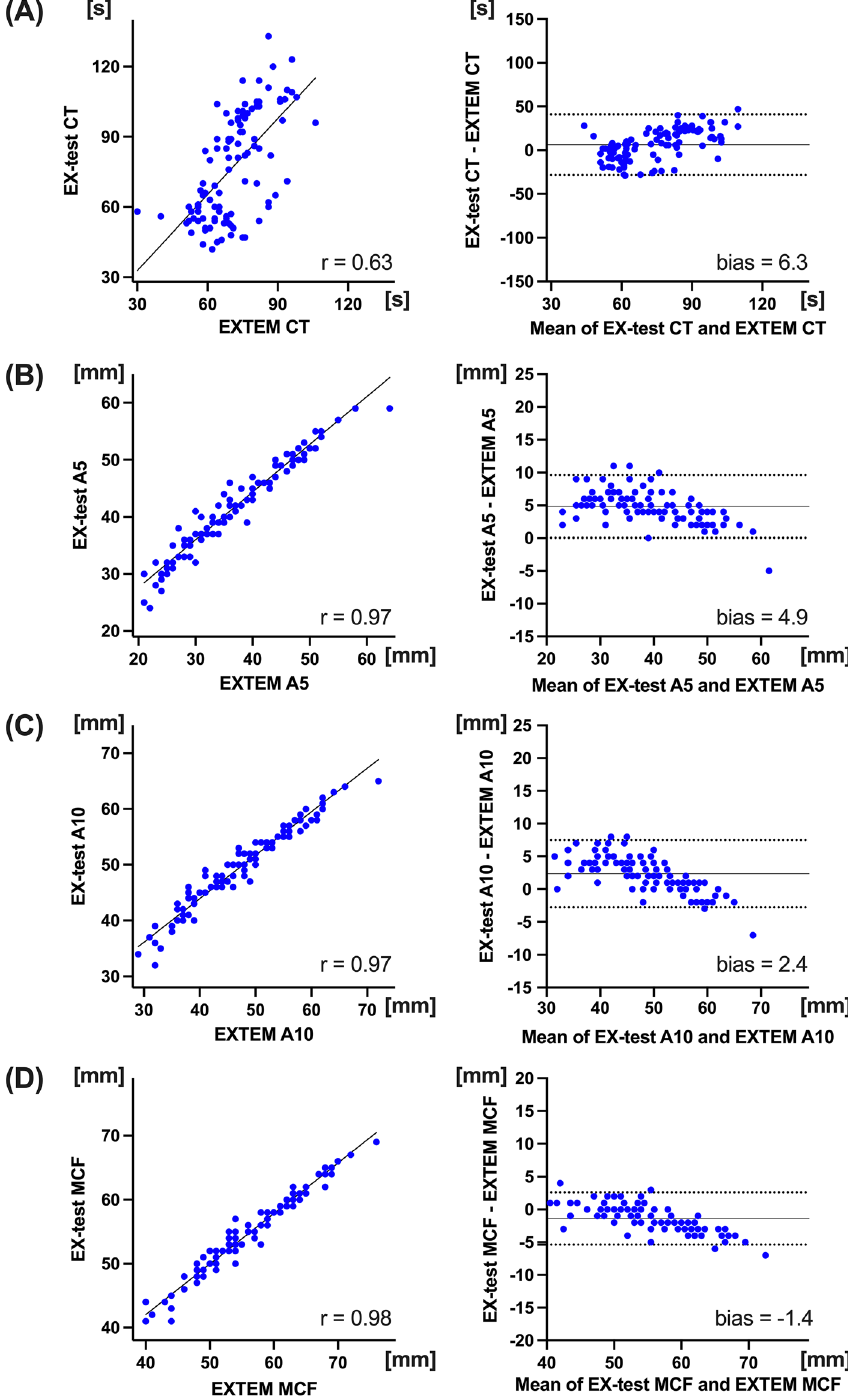
Figure 1. Relationship between EX-test and EXTEM. Linear regression and Bland–Altman analysis, between EX-test CT and EXTEM CT ( A ). Linear regression and Bland–Altman analysis of clot firmness, between EX-test and EXTEM; A5 ( B ), A10 ( C ), and MCF ( D ). Solid line in Bland–Altman analysis depicts bias, and dotted lines depict 95% limits of agreements. CT clotting time, MCF maximum clot